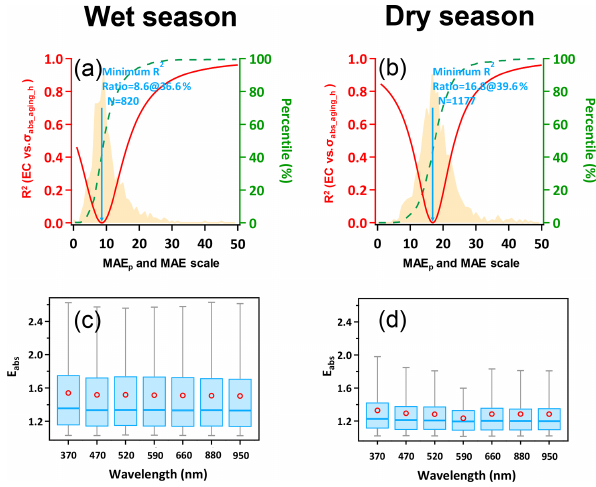
Figure 2. E abs determination by MRS. (a) Wet season MAE p de- termined by MRS at 520nm. The red curve represents the correla- tion coefficient ( R 2 ) between hypothetical σ abs_aging ( σ abs_total − EC · MAE p ) and EC mass as a function of MAE p_h . The shaded area in light tan represents the frequency distribution of observed MAE. The dashed green line is the cumulative distribution of ob- served MAE. (b) Same as (a) but for the dry season. (c) Spectral E abs determined by MRS in the wet season. Red circles represent the average values. The line inside the box indicates the median. Upper and lower boundaries of the box represent the 75th and the 25th percentiles; the whiskers above and below each box represent the 95th and 5th percentiles. (d) Spectral E abs in the dry